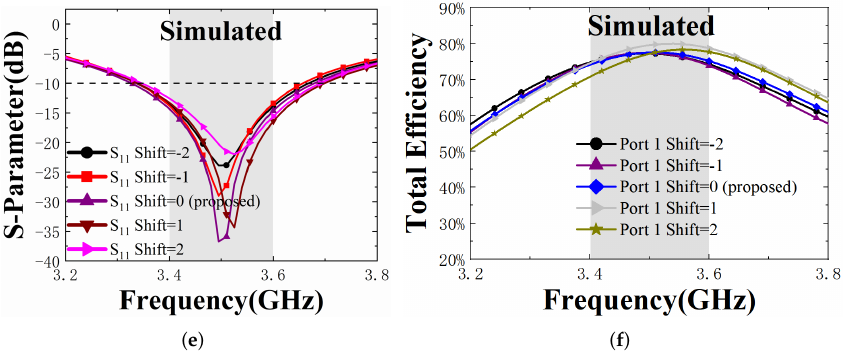
Figure 3. Simulated results of the proposed antenna for different values. ( a ) S-parameter for different S. ( b ) TE for different S. ( c ) S-parameter for different L.( d ) TE for different L. ( e ) S-parameter for different Shift. ( f ) TE for different Shift.